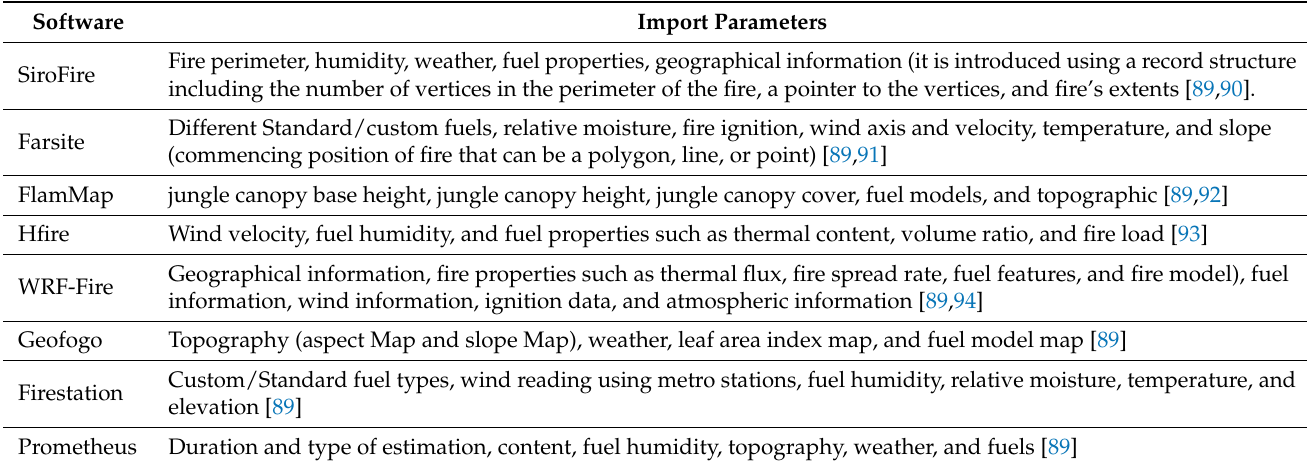
Table 2. The input parameters considered by fire simulation